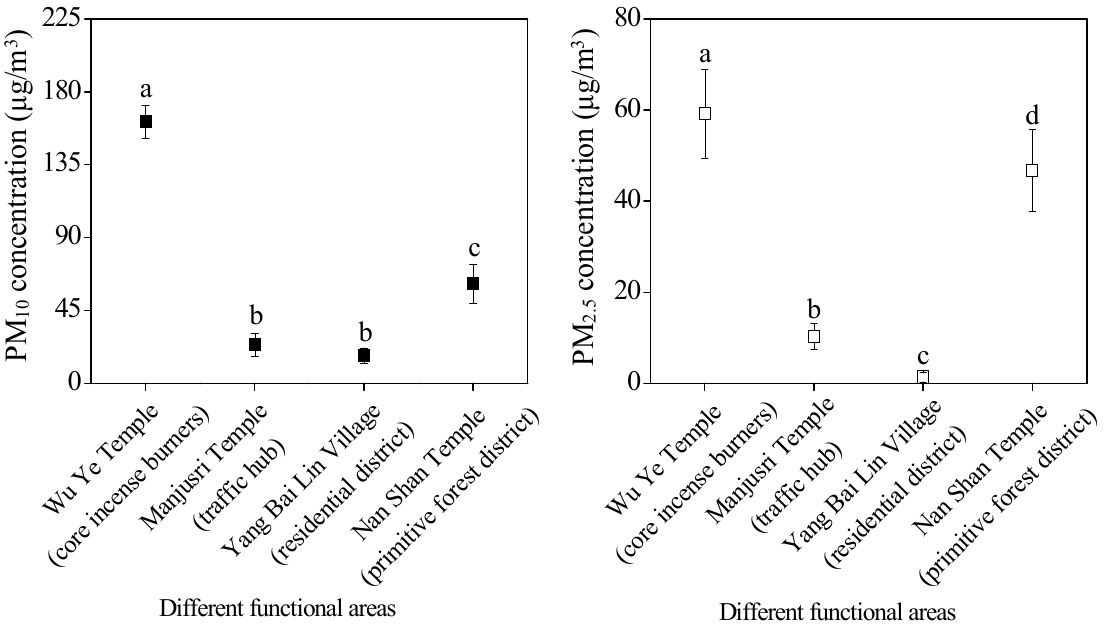
Figure 2. PM 10 and PM 2.5 concentration distribution in the four different areas at Mount Wutai, Shanxi, China. Data labeled in the point with the same letter are not significantly different at p < 0.05. The vertical T-bars indicated standard deviation about the